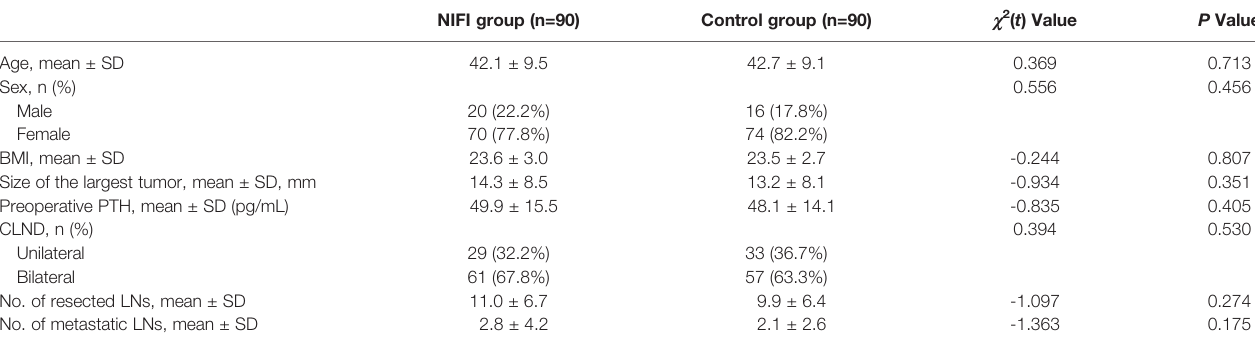
TABLE 2 | Demographics and baseline characteristics of the participants.